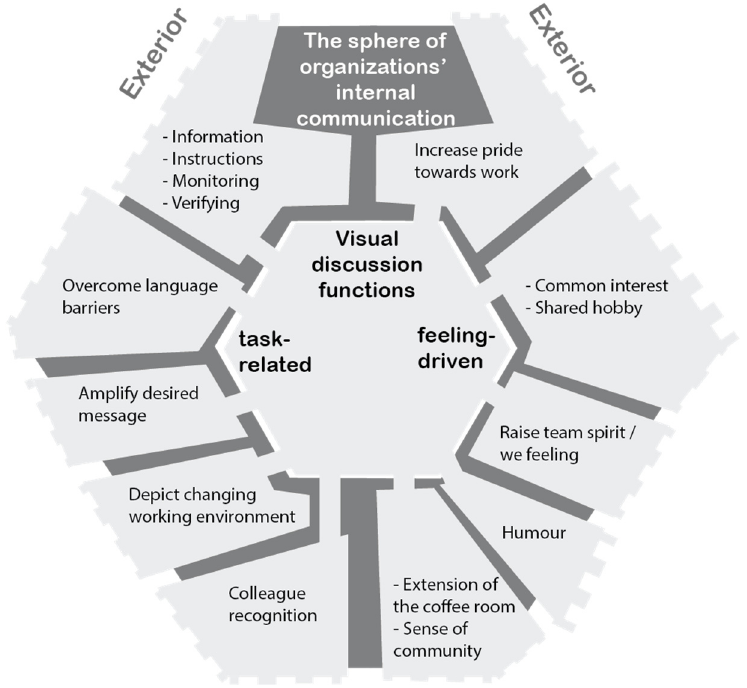
Figure 2. A summarized visual representation of the functions of visual discussions as part of internal communication in the studied organizations.